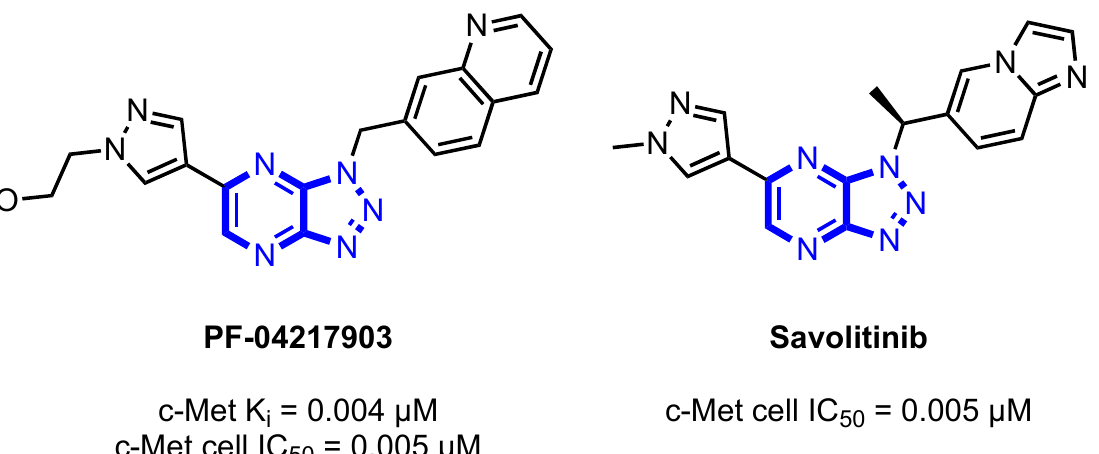
Figure 3. Two potent and selective c-Met inhibitors containing the 1,2,3-triazolo[4,5- b ]pyrazine core: PF-04217903 and Savolitinib.